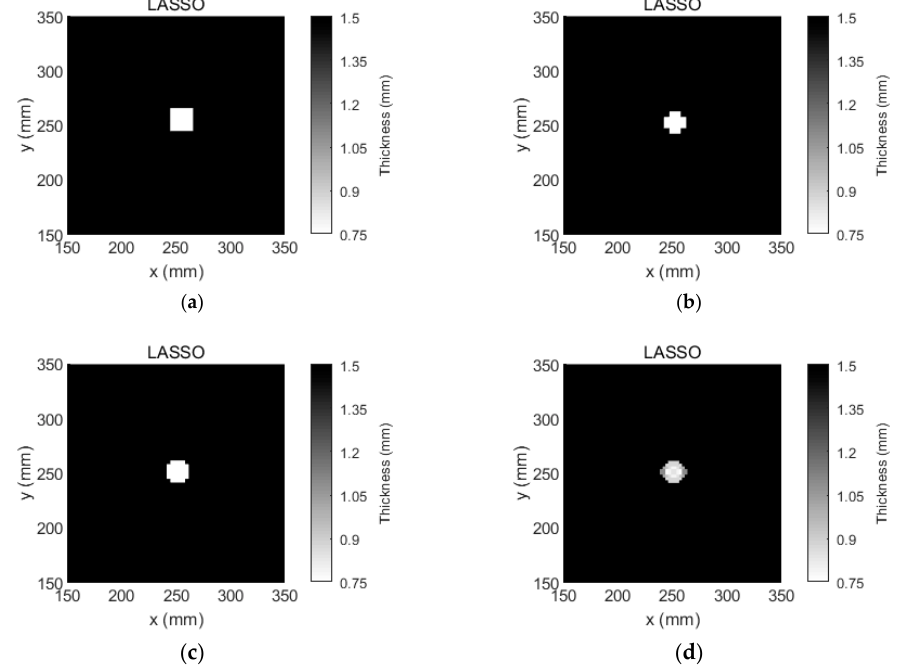
Figure 7. Tomographic reconstruction images for a 1.5 mm thick aluminum plate with a 20 mm diameter circular flat-bottomed hole with di ff erent grid density using the proposed method. The thickness loss was 50% within the flaw. ( a ) The number of grids was 20 × 20, ( b ) the number of grids was 40 × 40, ( c ) the number of grids was 60 × 60, and ( d ) the number of grids was 80 ×